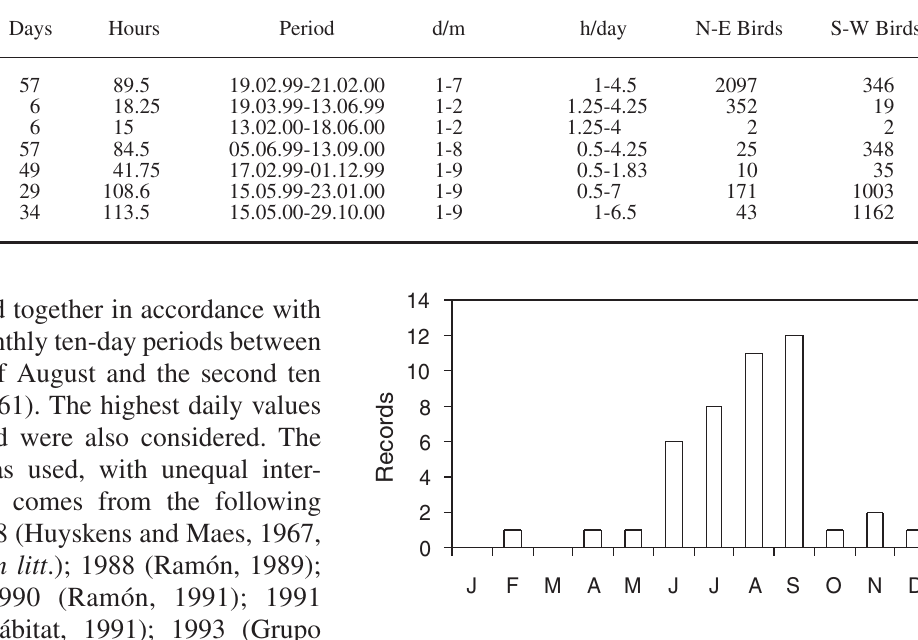
F IG . 2. – Monthly distribution of the records of more than 150 birds, obtained for the 1976-2000 period.